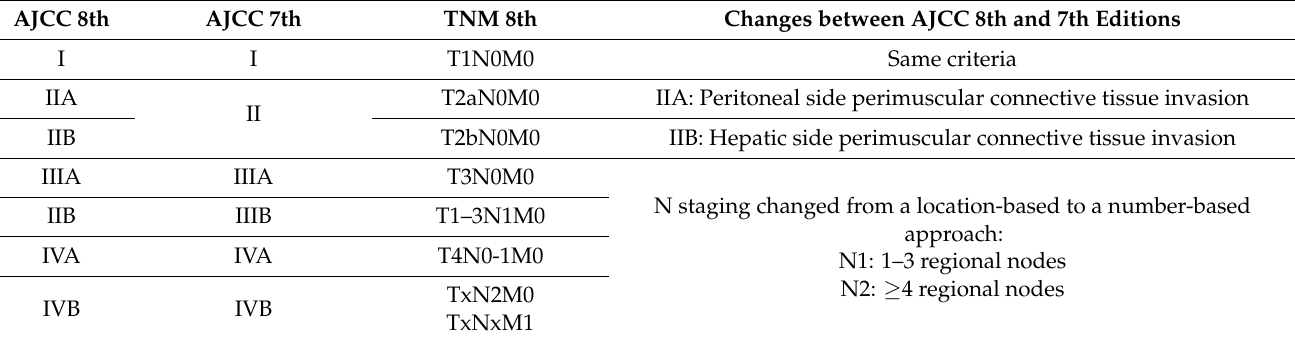
Table 1. American Joint Committee on Cancer (AJCC) 8th vs. 7th classification staging criteria of patients with gallbladder cancer (GBC).